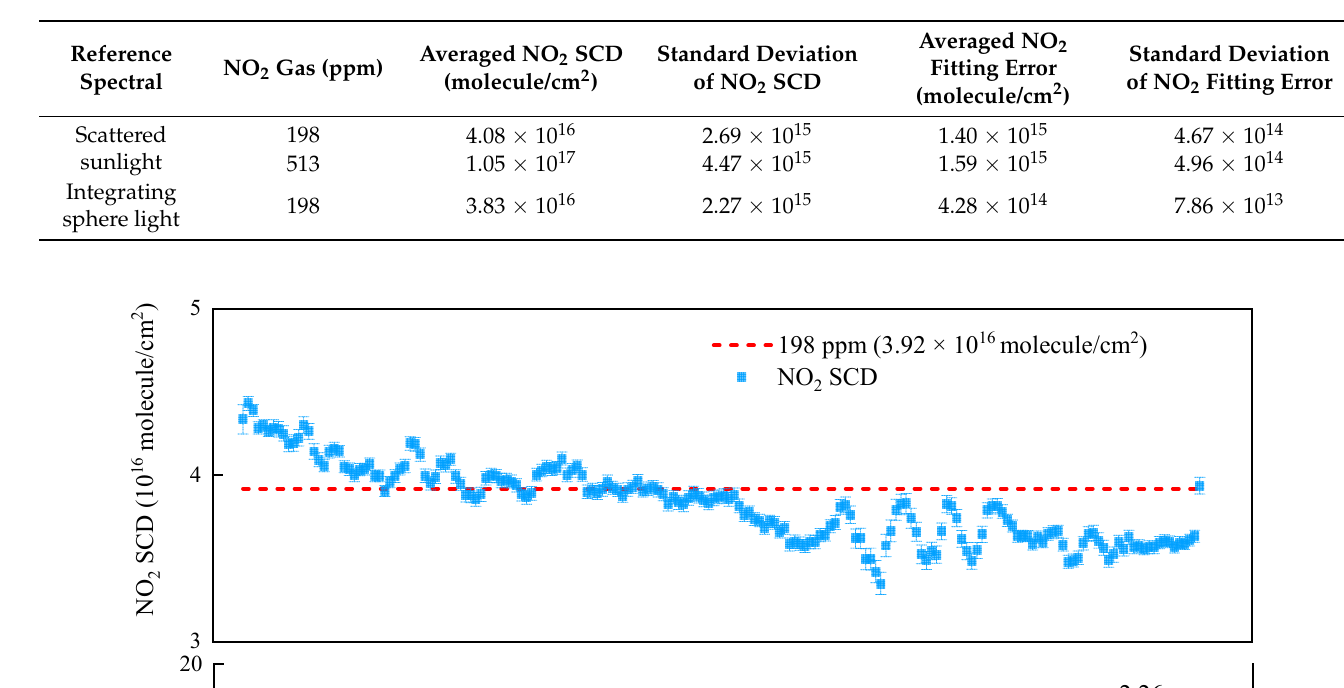
Table 3. NO 2 gas cell measurement results of the nadir module.